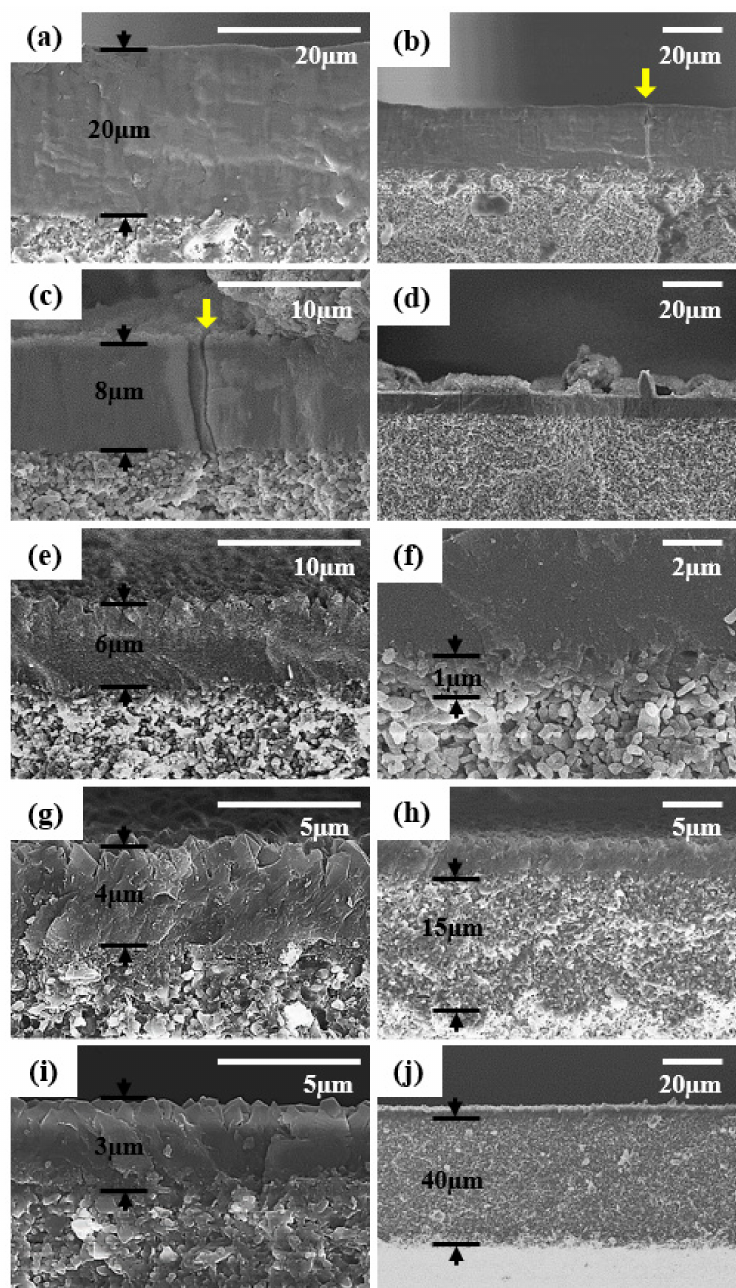
Figure 6. Cross-sectional SEM images of synthesized CHA zeolite membranes using planetary-milled ( a , b ) S1, ( c , d ) S2, ( e , f ) S3, ( g , h ) S4, and ( i , j ) S5 seed samples. The yellow arrow shows site of cracks in the zeolite